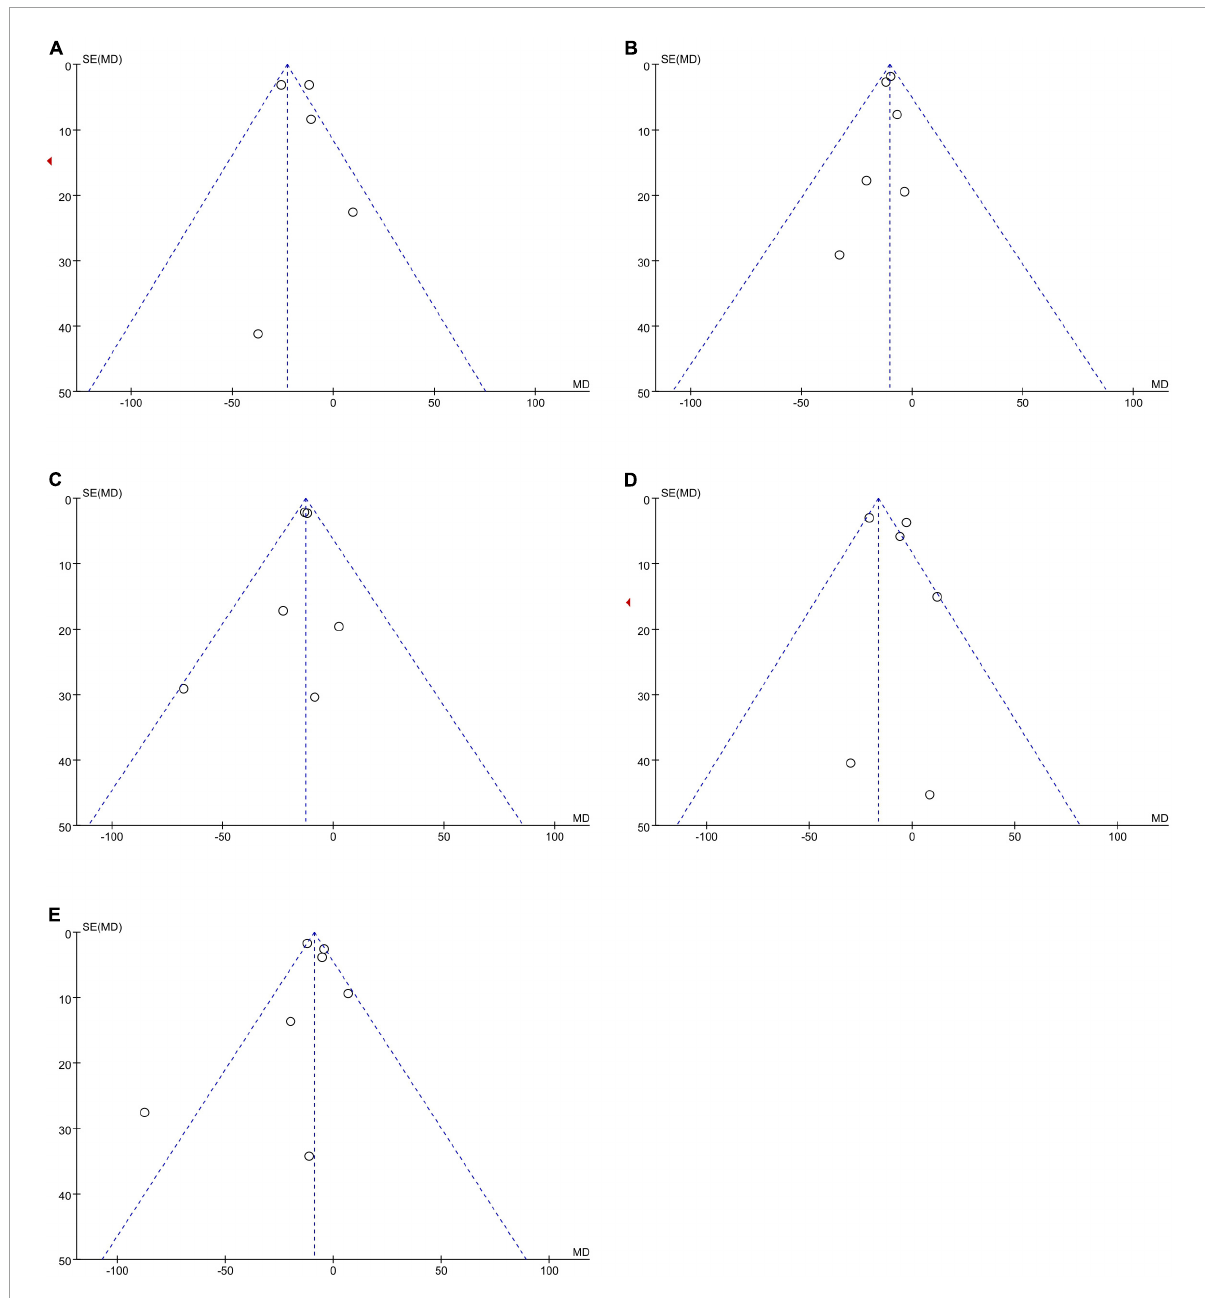
FIGURE4 Funnel plots to assess the publication bias related to the dabigatran trough concentrations: (A) homozygote model, (B) heterozygote model, (C) dominant model, (D) recessive model, and (E) allelic model.